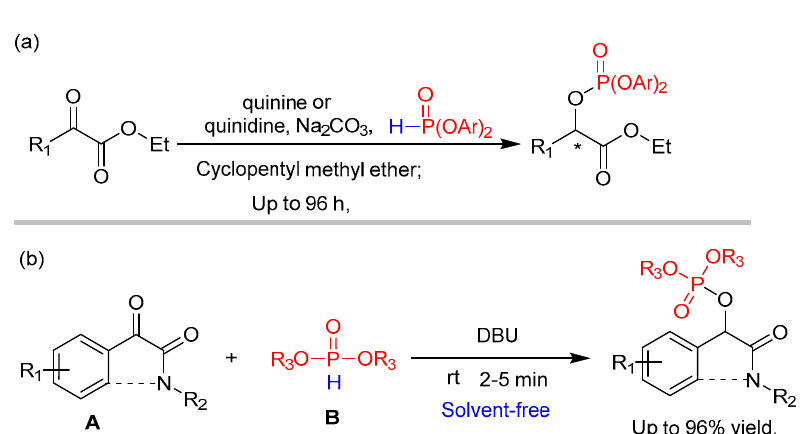
Figure 1. The synthesis of novel phosphates derivatives via Phospho ‐ Aldol ‐ Brook Rearrangement. ( a ) Nakamura’s work [25]; ( b ). This work.